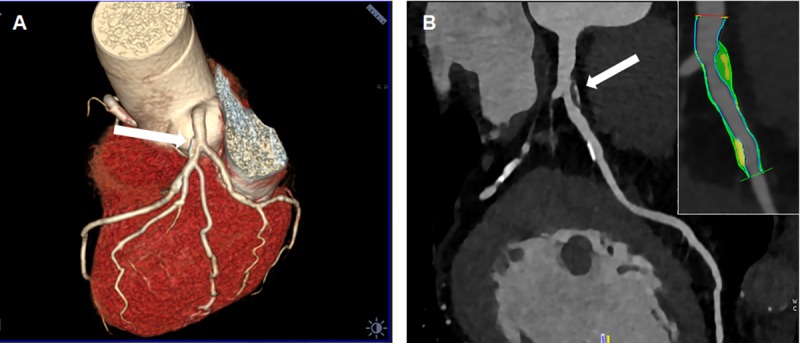
(A) 3D volume rendering and (B) Curved multi planar reconstruction of a left anterior descending artery showing a proximal mostly non-calcified plaque with a spotty calcification (white arrow in (A) and (B) panels) and a distal calcified plaque. Semi-automatic segmentation of coronary vessel: calcified component (yellow), lipid component (green) and fibrotic (blue).